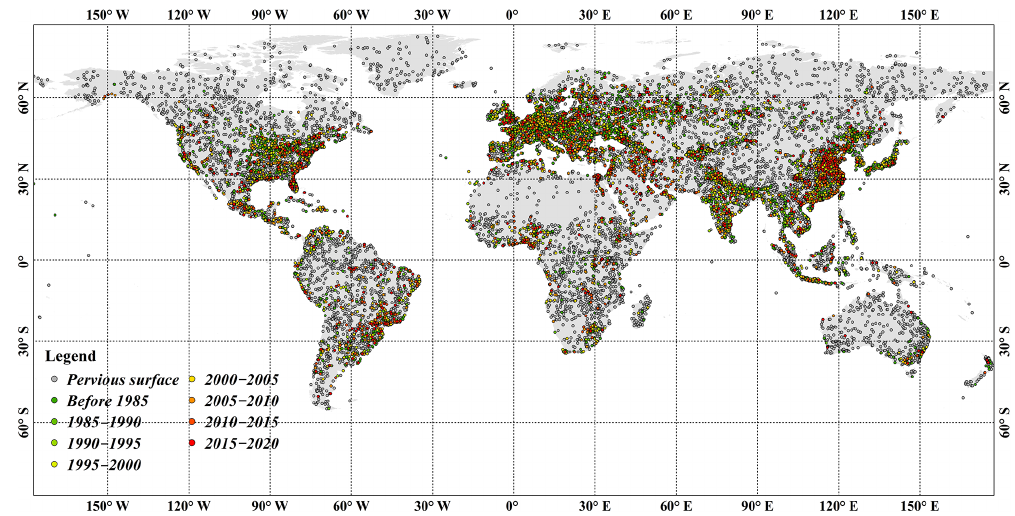
Figure 2. The spatial distribution of the global multitemporal impervious-surface validation dataset for